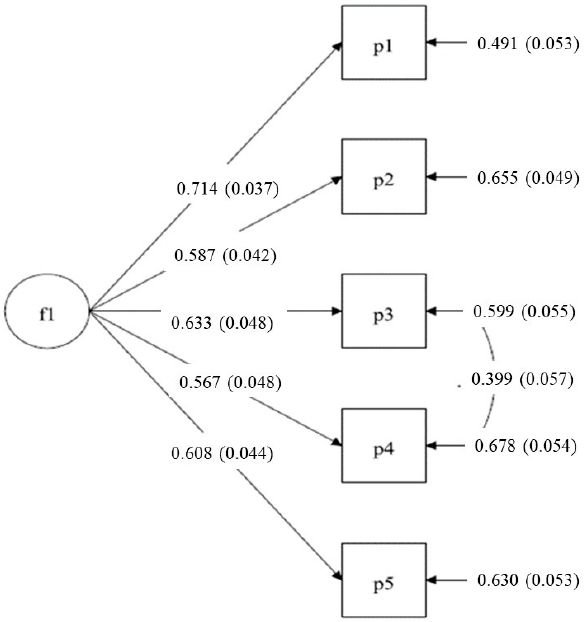
Figure 1. Standardized solution of final model.